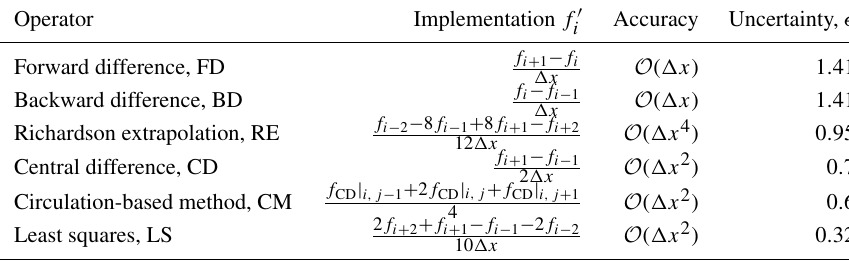
Table 2. Summary of differentiation schemes and implementation a .